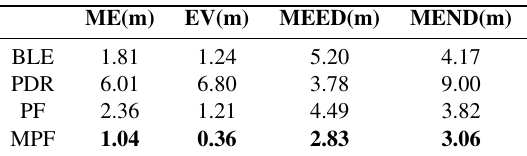
Table 1: The positioning results of the second trajectory.